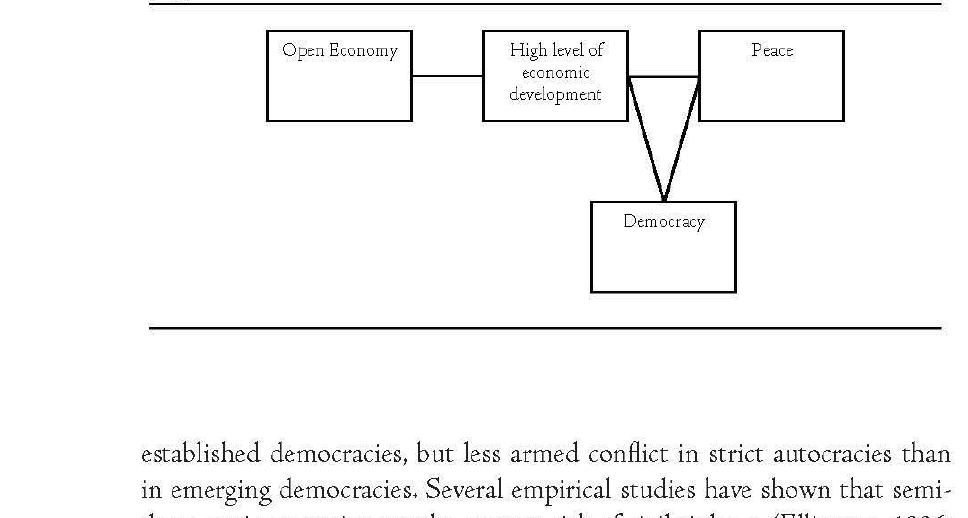
Figure 1: A Liberal